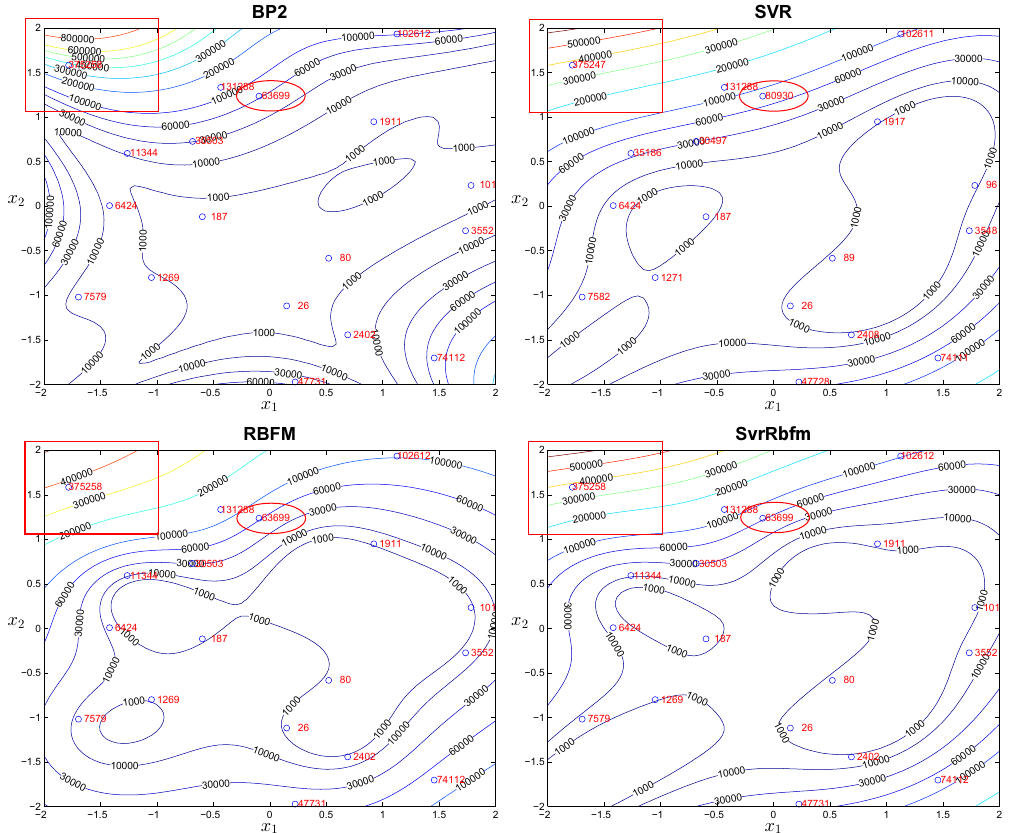
Figure 4. Contour plot of the actual function and the approximate functions of SVR, RBFM, and